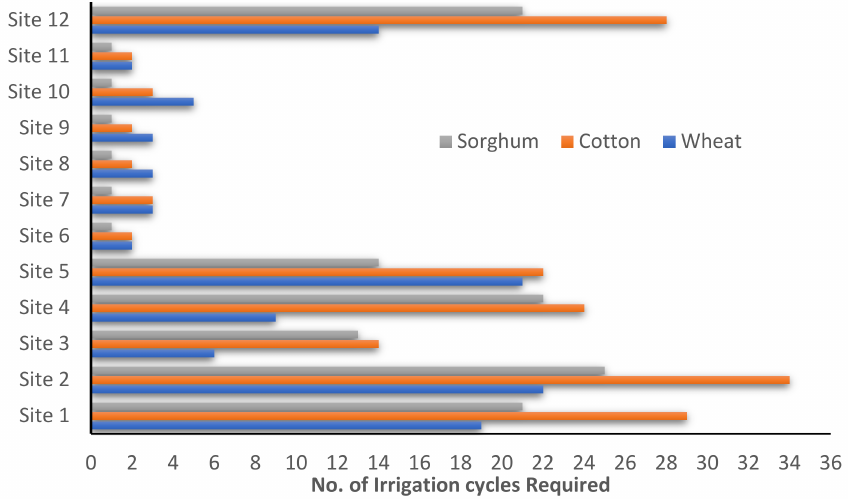
Figure 18. Number of irrigation cycles required at different sites for different crops.